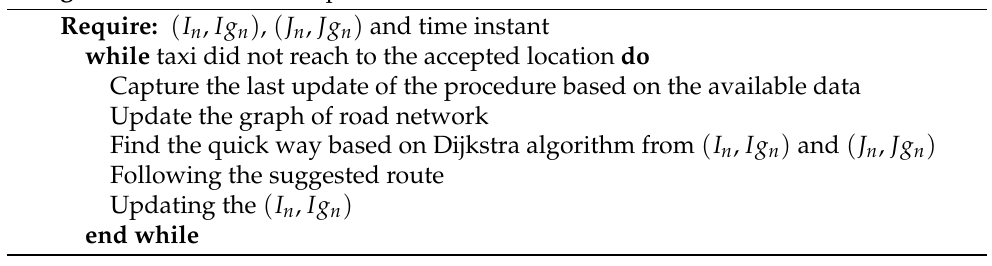
Algorithm 1: Taxi Route Optimizer Procedure.